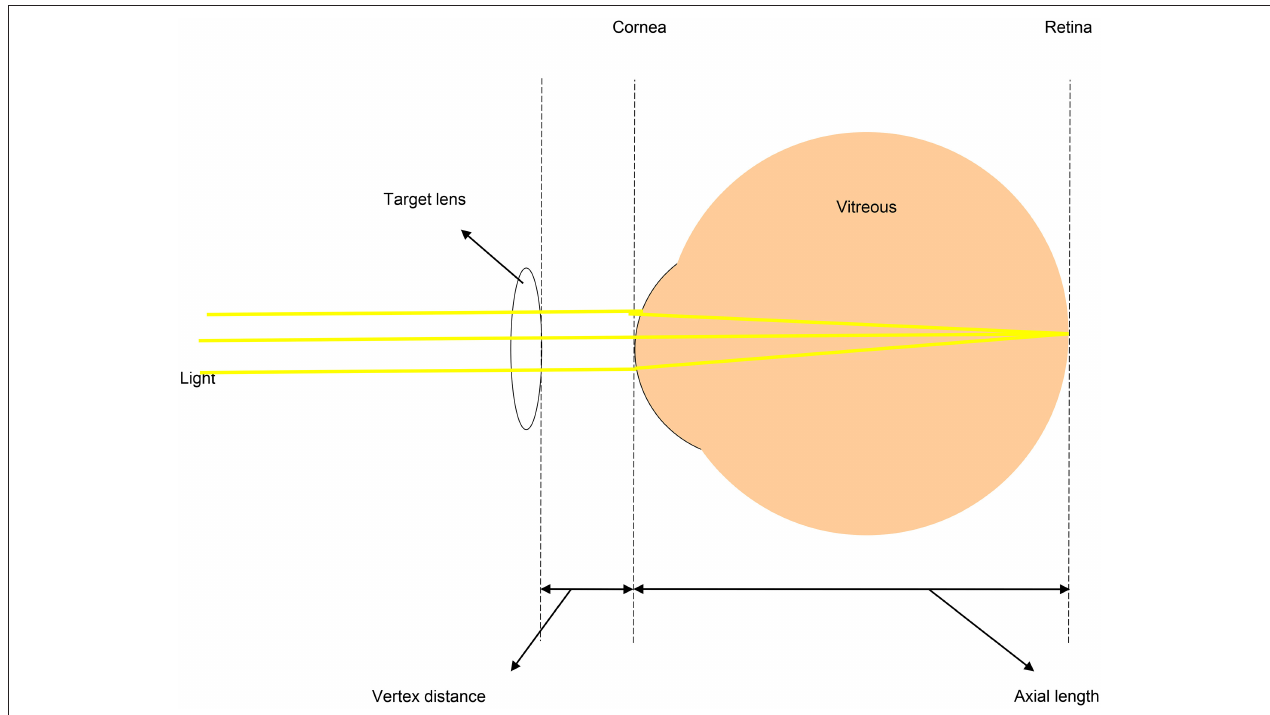
FIGURE 1 | Schematic diagram showing paraxial rays focused on the retina of an aphakic eye. In aphakic eyes, the main refractive media are the cornea and vitreous cavity. If these two structures are regarded as a combined pair of thin lenses, the refractive value of the eyeball can be calculated using a simplified vergence